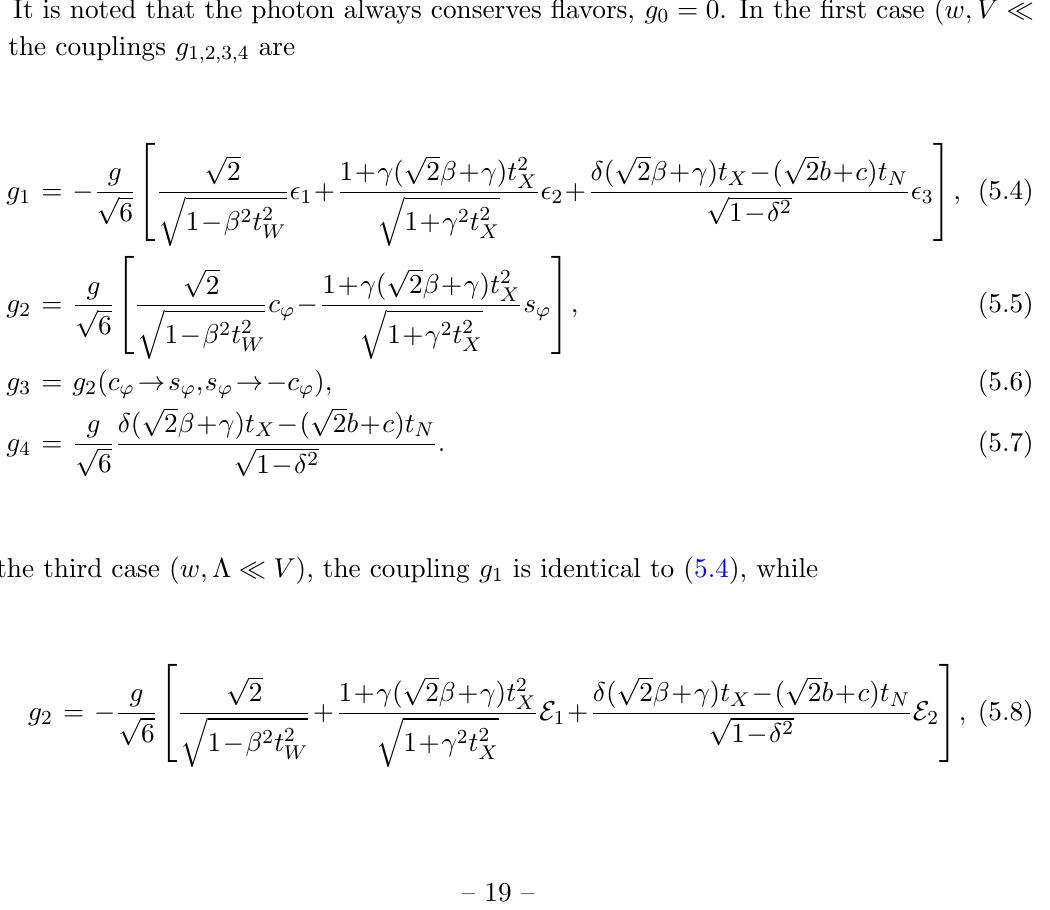
3 , where the red, = 10 (cid:30) 1 , 2 , 3 − | | 1 / √ 3 , γ = 1 / √ 6), − −